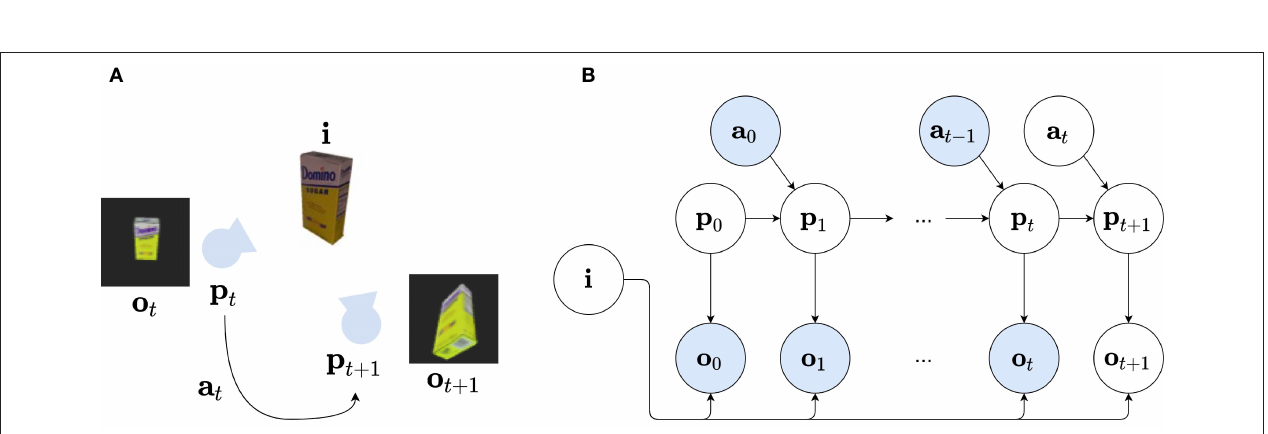
FIGURE 2 | (A) Visual representation of the environment in which an object with identity i (in this case: sugar box) can be observed by a camera at a pose p t , relative to the object. The agent can transform this viewpoint, provided it performs action a t + 1 to go to pose p t + 1 . At each pose, an observation o t is perceived. (B) The Bayesian Network describing the generative model of the agent. The variable i represents the identity of the observed object, p t represents the latent representation of the camera pose at timestep t . The variable o t represents the sensory observation and is dependent on the identity i and pose variable p t . The current camera pose p t is dependent on the previous pose p t − 1 and action a t − 1 of the agent. Again observed variables are shown in blue, while unobserved variables are shown in